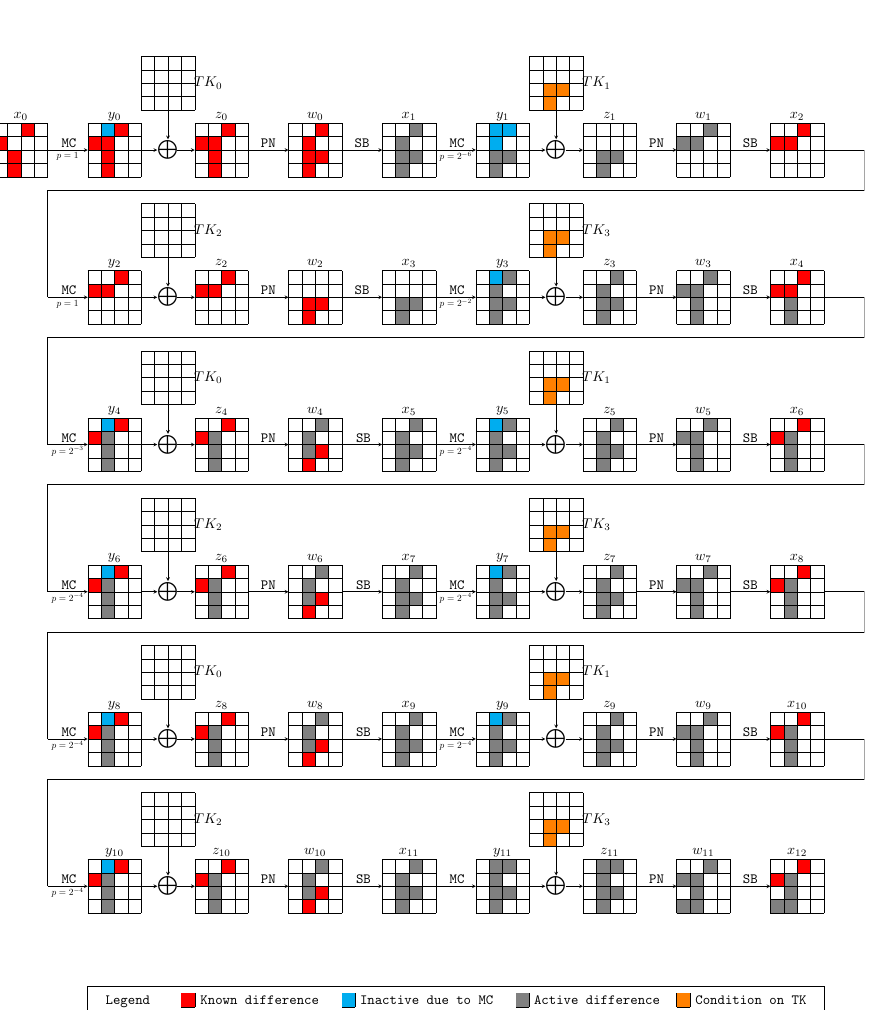
Figure 13: A 12-round truncated differential trail of CRAFT with probability 2 −